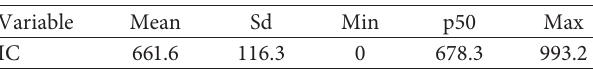
Table 5: Descriptive statistics of